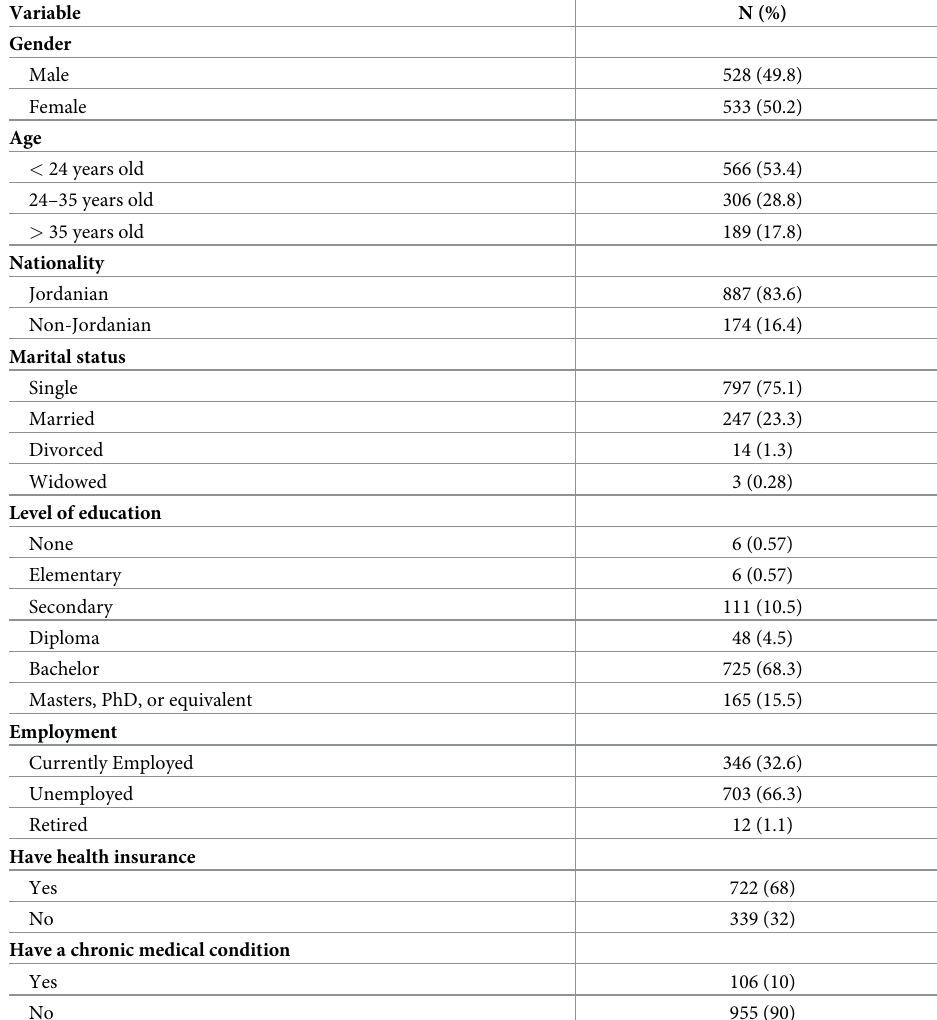
Table 1. Socio-demographic characteristics of